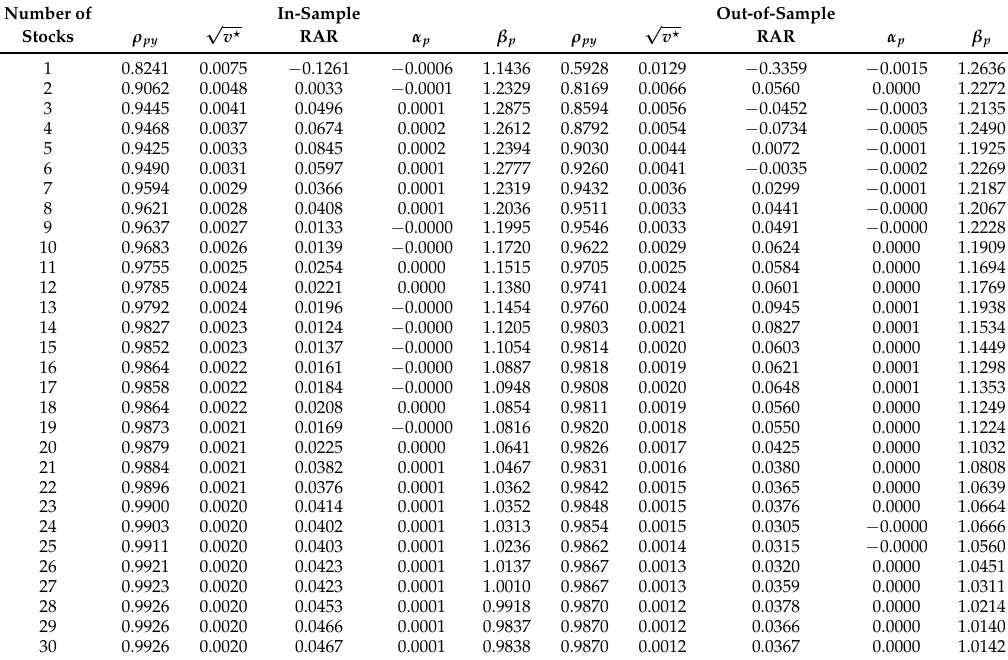
Table 4. Optimal tracking portfolios for DJIA index: Algorithm